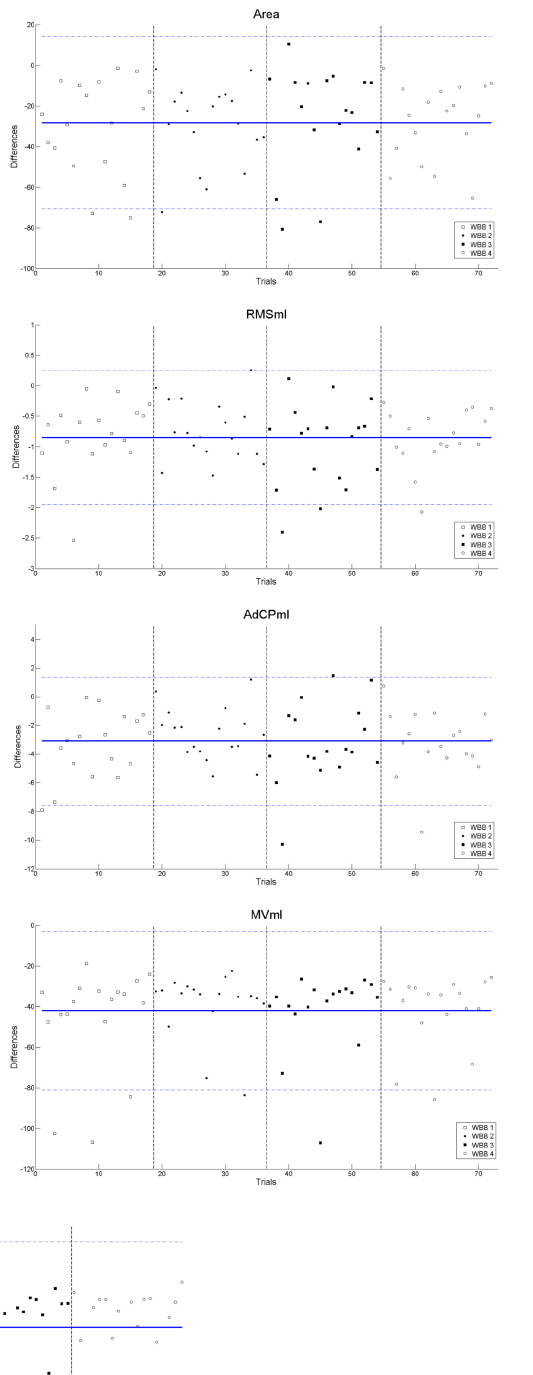
Figure 2. Differences between force plate and Wii Balance Boards for the 72 trials. Solid horizontal lines represent the mean difference. Dotted horizontal lines represent upper and lower confidence intervals (95%). Vertical lines indicate separation between the 4 different devices (18 trials per Wii Balance